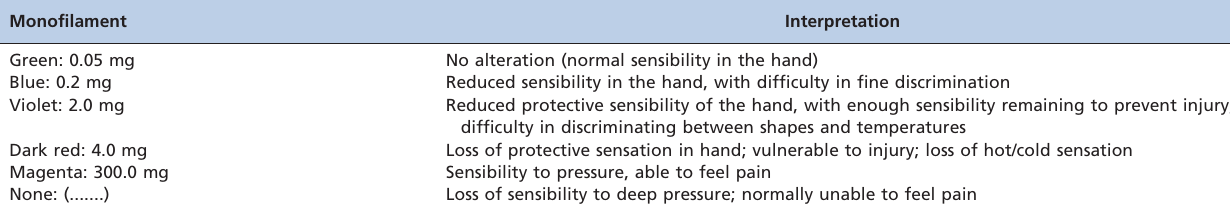
Table 1 - Monofilament test results and interpretations.